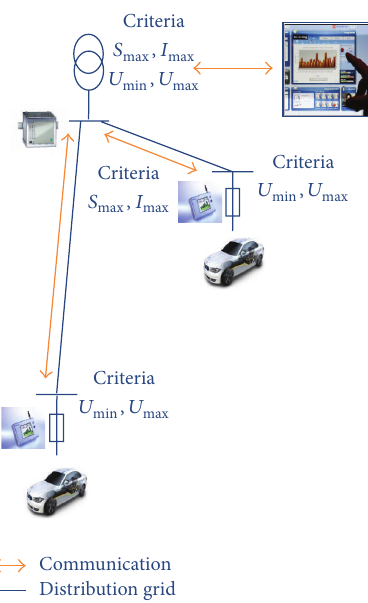
Figure 4: Architecture